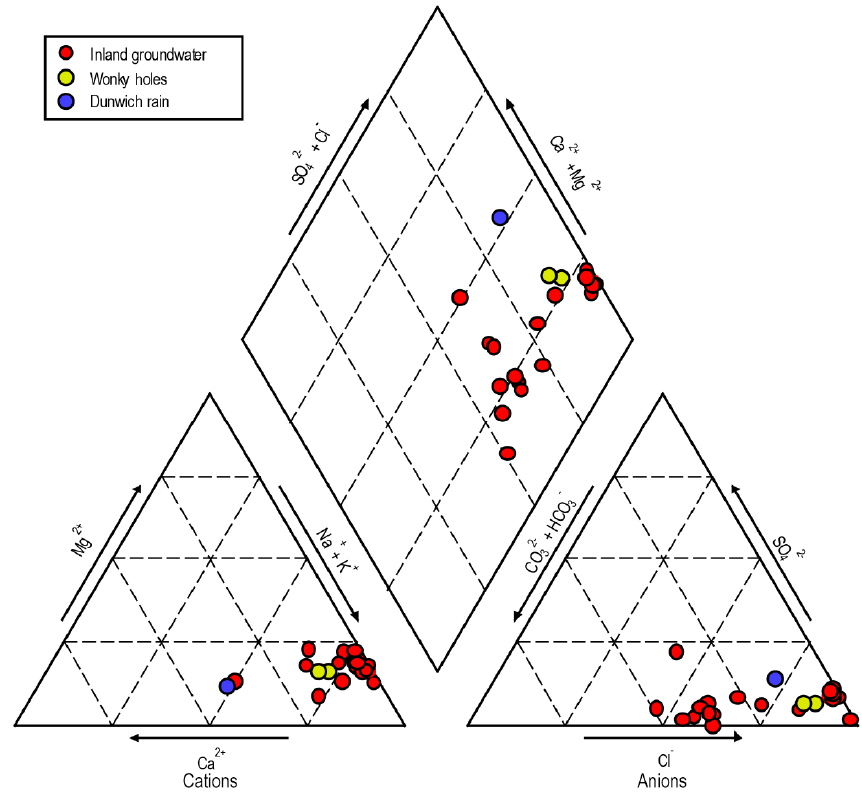
Figure A3. Piper diagram showing inland groundwater samples (red), samples from the two wonky holes (yellow) and the rain water sample